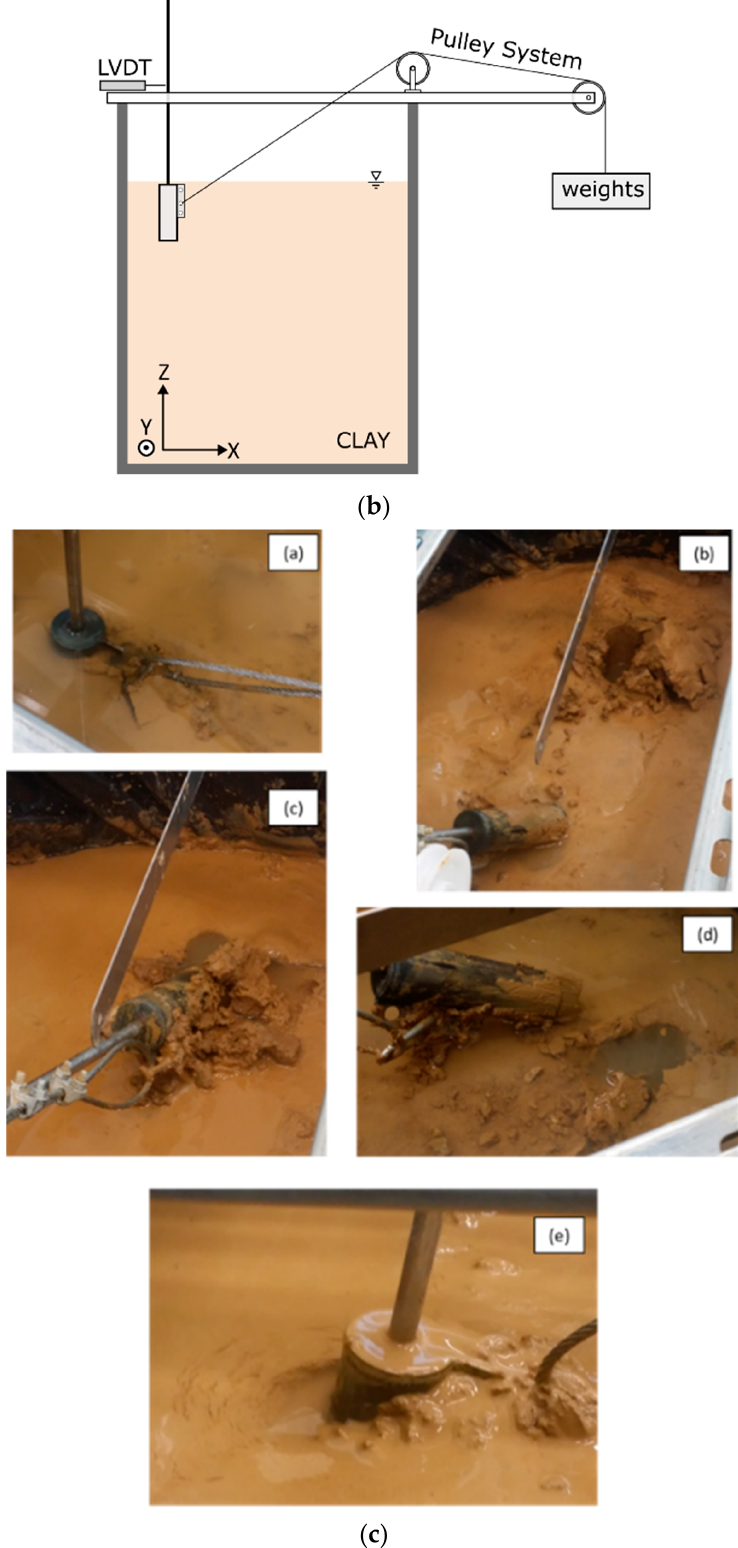
Figure 22. ( a ) Load transfer to the anchor and to verify the above hypothesis of failure mechanism. ( b ) Schematic of the test setup. ( c ) Example of understanding the failure mechanism of the anchor for different locations of the padeye.